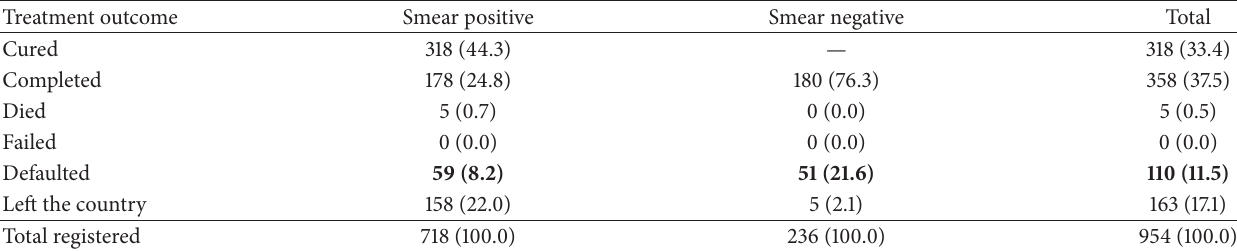
Table 1: Outcome of pulmonary tuberculosis treatment by sputum smear status (for the years 2004–2006).